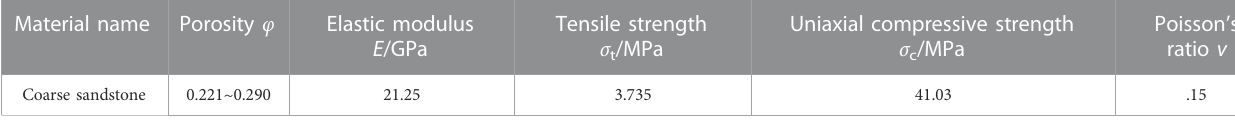
TABLE 1 Structural and mechanical characteristic parameters of sample materials (Huang et al., 2018; Zhao, 2019).